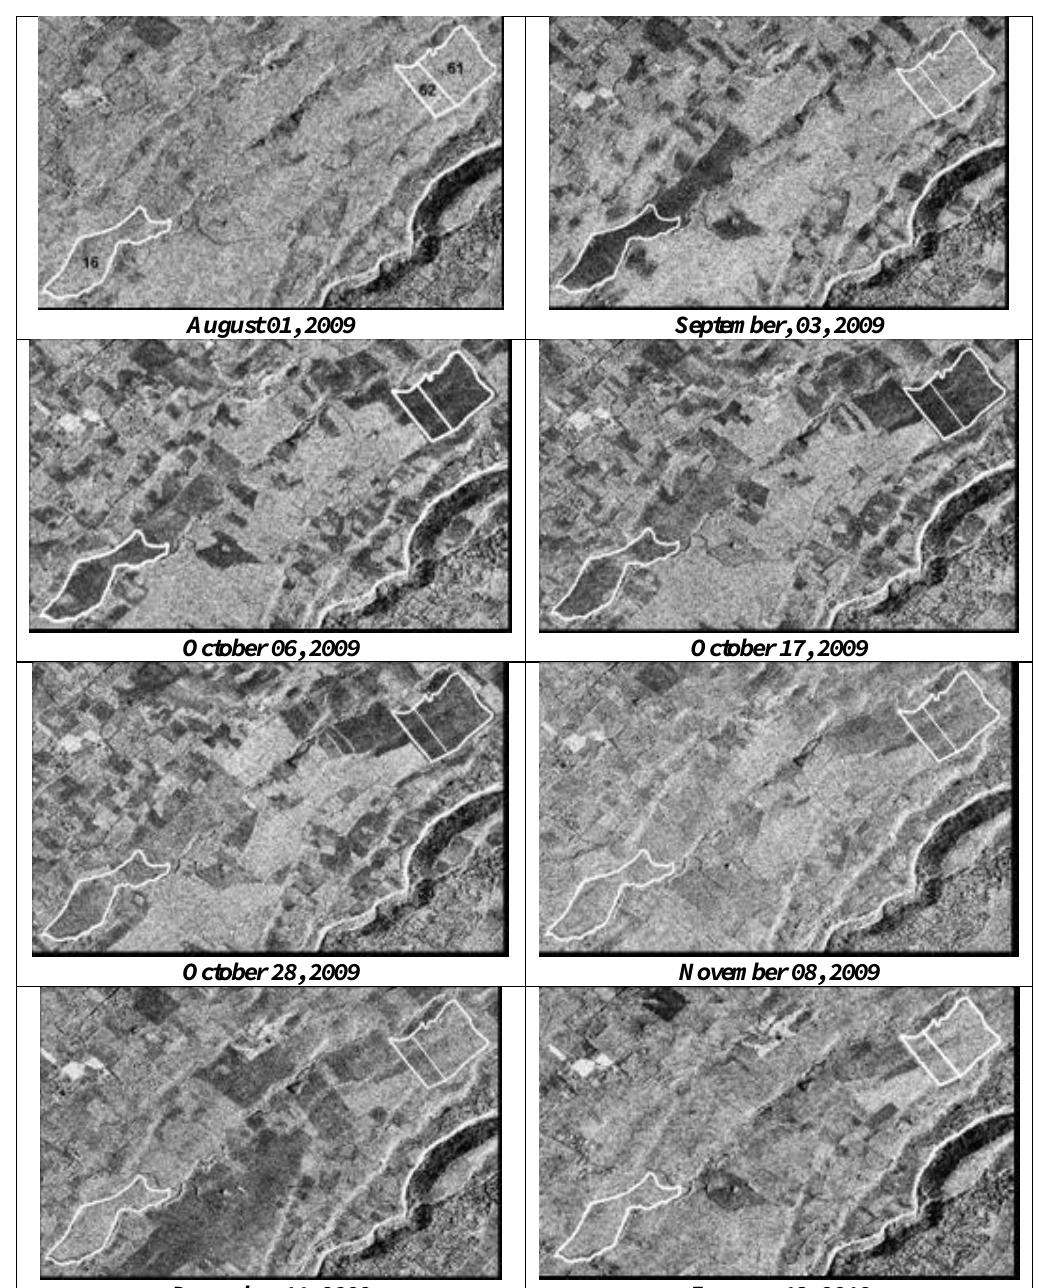
Figure 8. Comparison of several TerraSAR image segments for reference sugarcane fields (61, 62, and 16). All images were acquired at incidence of 37° and in VV polarization. Fields 61, 62, and 16 were harvested on September 10, October 03, and August 29, 2009,